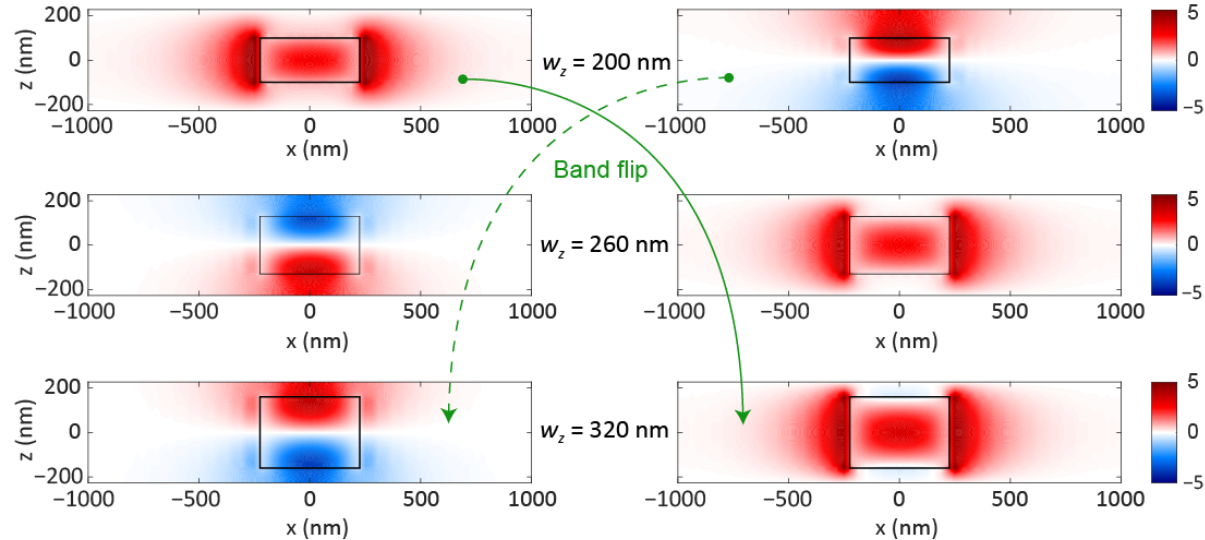
Figure 3. E y field maps at the boundary of the first Brillouin zone for the dielectric (left column) and air (right column) bands at different values of w z . For w z = 260 nm (middle panels) the frequency difference between the two bands is negligible, meaning that they are close to the degeneracy point.